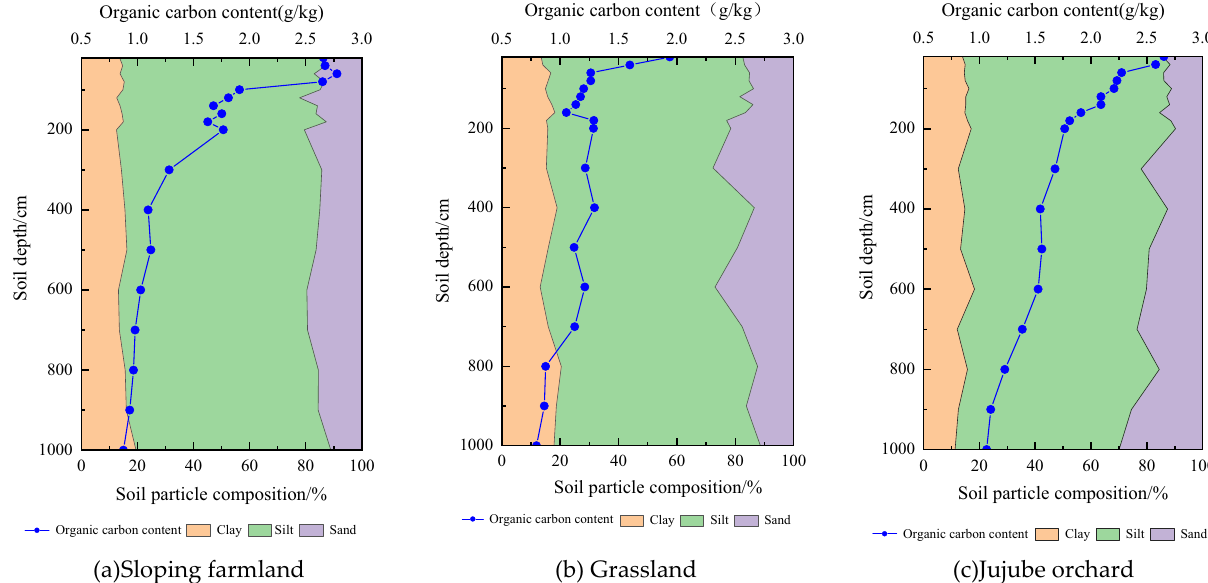
Figure 1. Vertical distribution of soil particle composition and organic carbon mass fraction. Sloping farmland ( a ), Grassland ( b ), Jujube orchard ( c ).